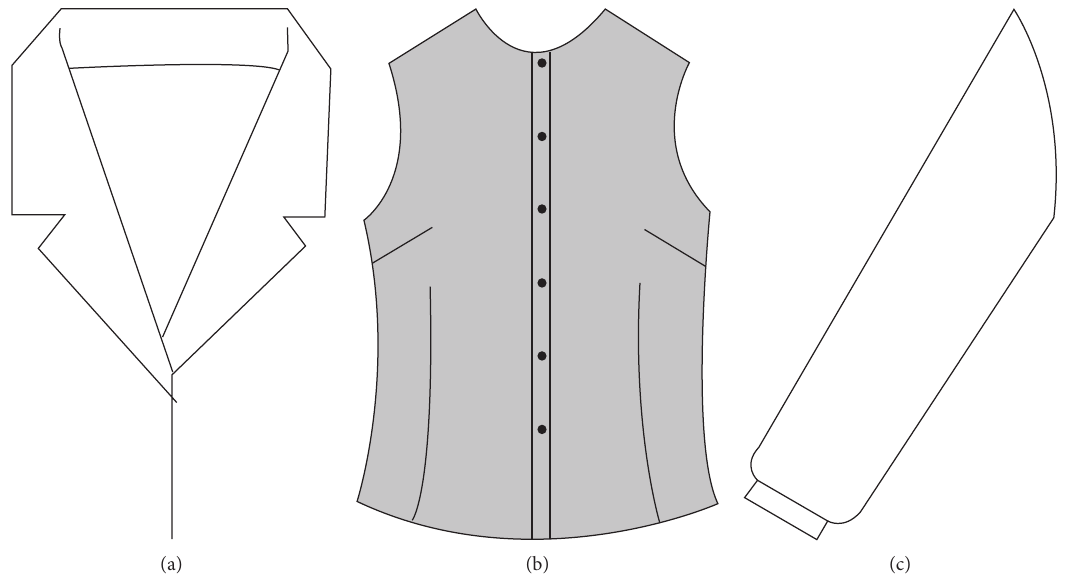
Figure 12: Garment without segmentation of cutting pieces. (a) Garment. (b) Cutting pieces of garment. (c) Sleeves.